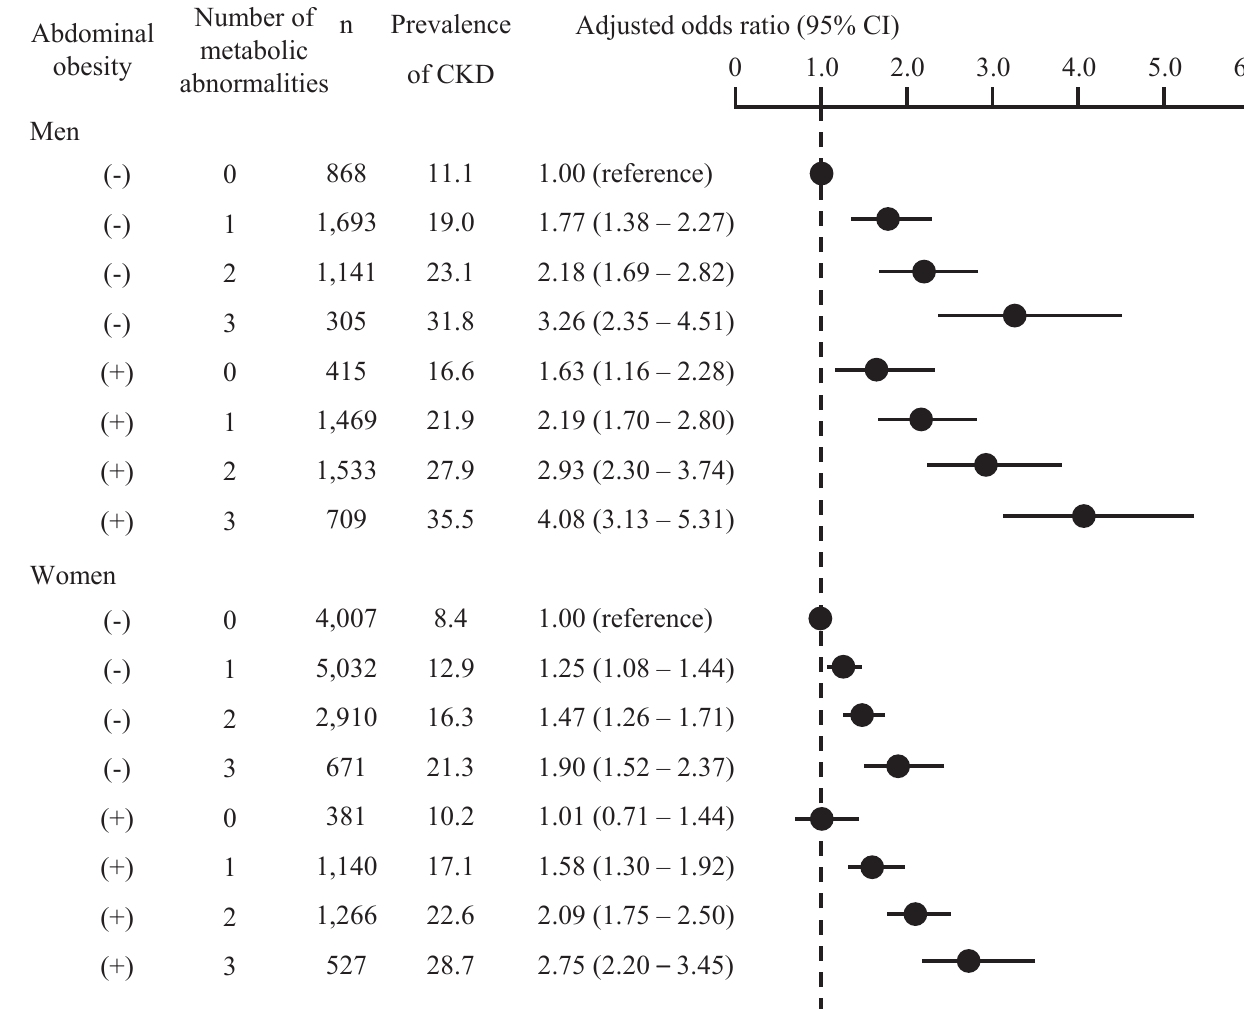
Table 3. Prevalence of abdominal obesity, number of complicated metabolic abnormalities, and odds ratios of renal dysfunction in Japanese men and women Number of metabolic Abdominal obesity abnormalities Low eGFR ( − )